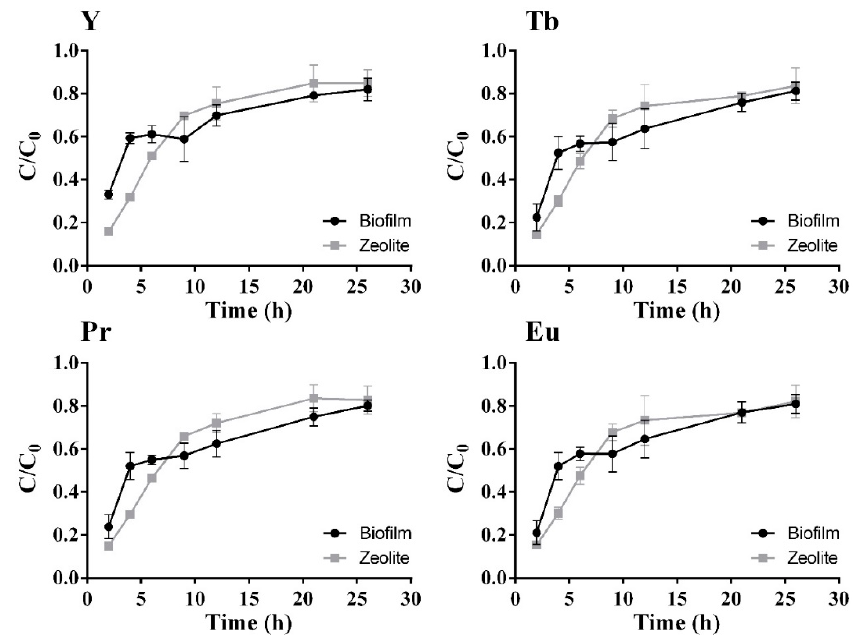
Figure 11. REE C/C 0 over time with initial total concentration of 10 mg/L for the multiple-component solution. The adsorption of all the elements by zeolite with ( ) or without biofilm ( ) is presented with the respective standard deviation ( n = 2, X = 2).